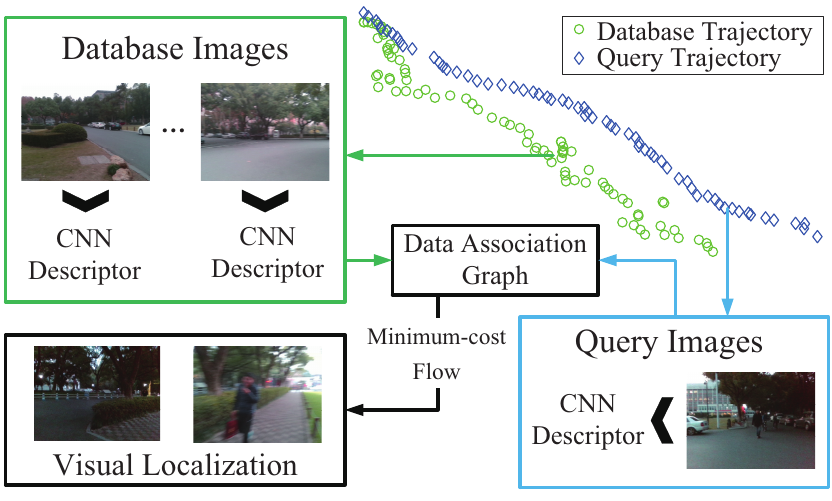
Figure 2. The general diagram of proposed Visual Localizer for visually impaired people. The entire framework is bipartite: ConvNet-based image description and network flow model-based image